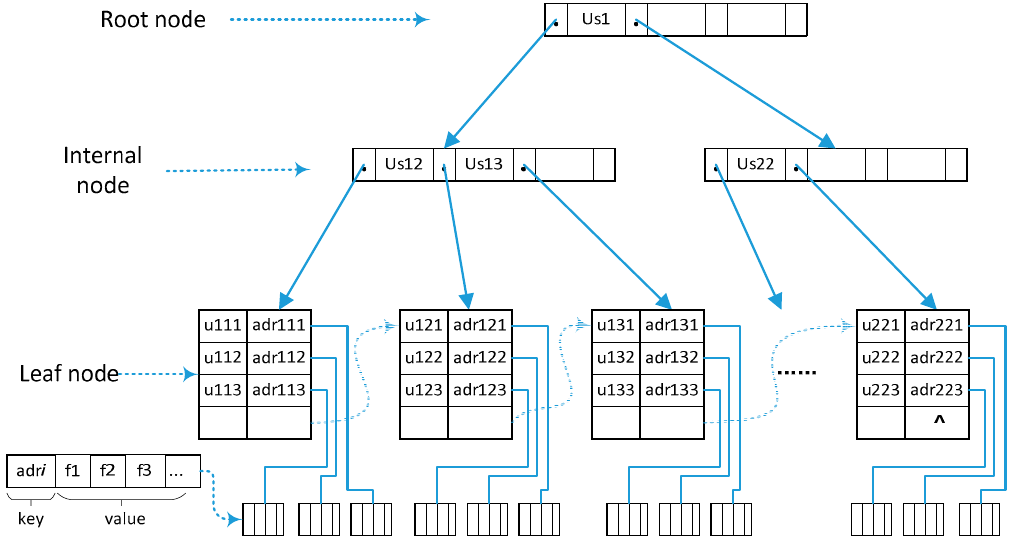
Figure 9. The B + -tree index structure of “User Block Figure 9. The B+-tree index structure of “User Block Set”.